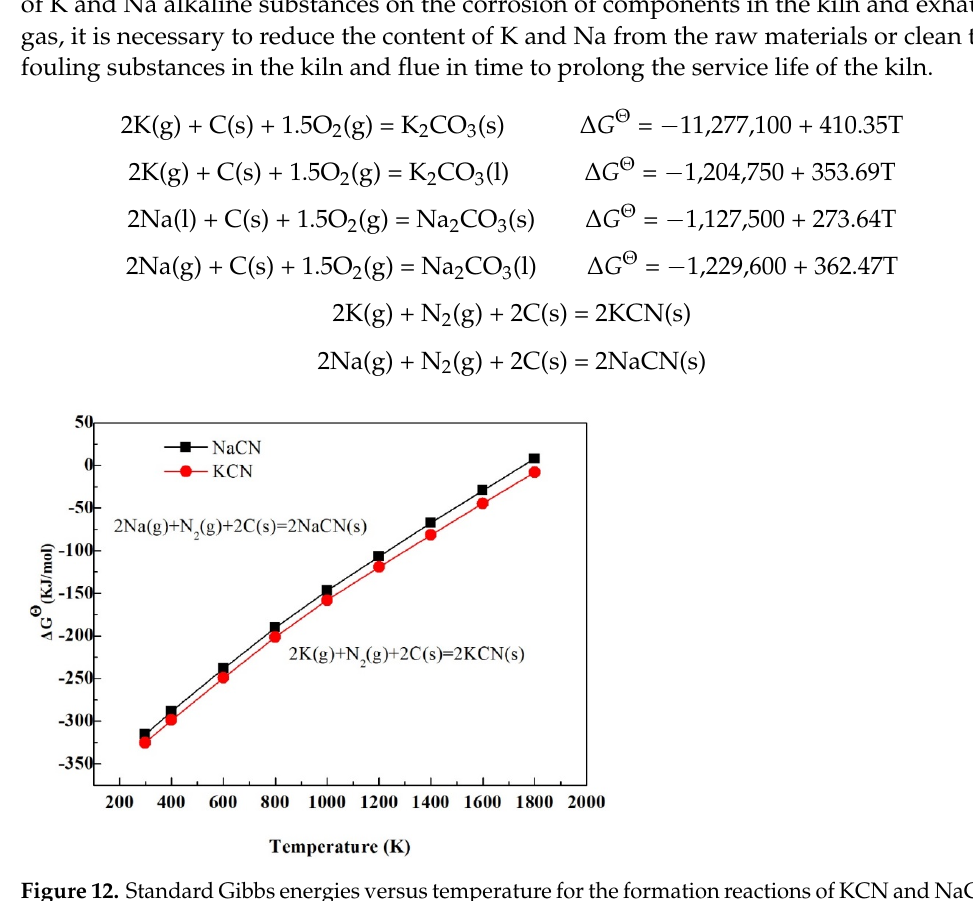
Figure 12. Standard Gibbs energies versus temperature for the formation reactions of KCN and NaCN.